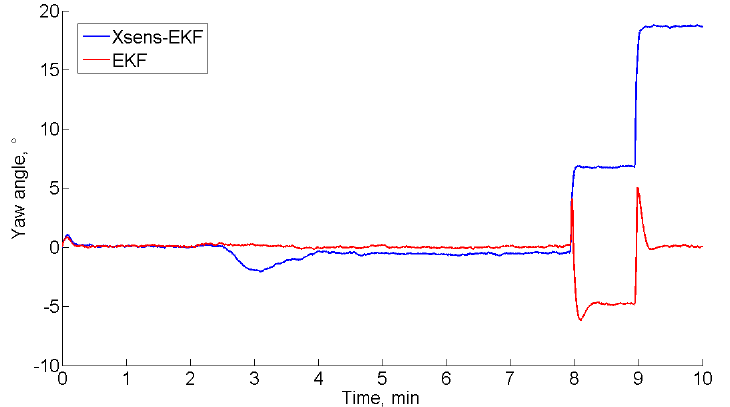
Figure 4. Heading angle time function estimated by the EKF-M σ = ( 0.01 a.u./s). b h